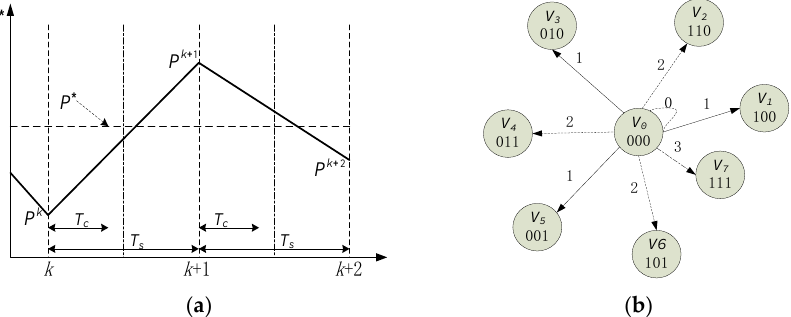
Figure 4. (a) . Data processing in digital implementation. (b) . switching paths.